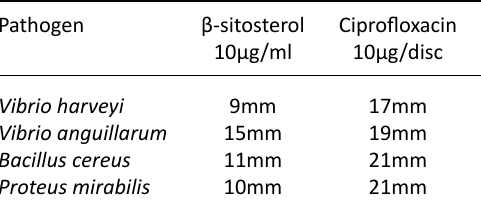
Table 4. Results of antibacterial activity of Parthenium hysterophorus extracts and pure compound Pathogen